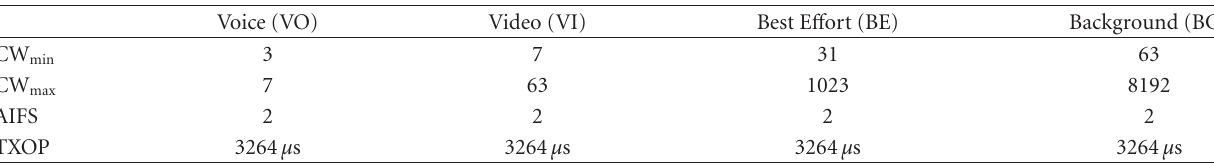
Table 1: EDCF parameter set.